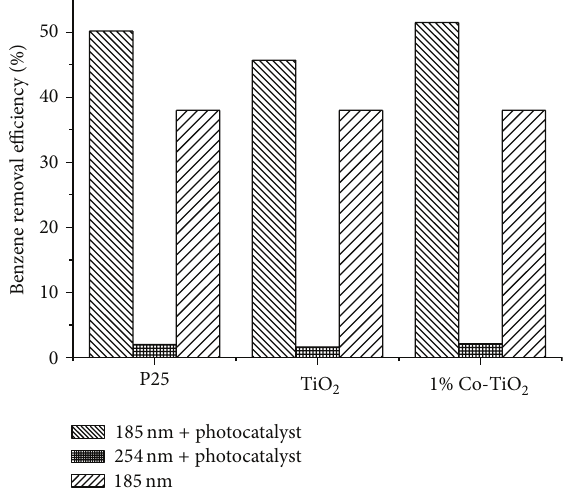
Figure 4: Benzene removal efficiency in different